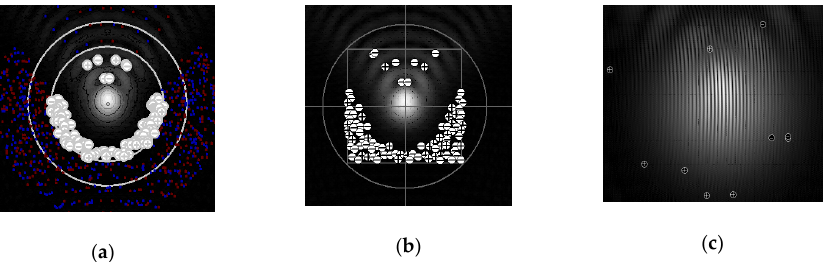
Figure 8. Distributions of singular points in a beam with a phase profile set by polynomial No. 8 (coma). The dislocations are shown by circles with «+» or « − » signs. To register optical vortices three algorithms were used. Firstly, vortices were localized by processing distribution of wavefront gradients ( a ); secondly, as a point of intersection of isolines ( b ); and with application of interferometric algorithm ( c ). The number of the found singular points N dsl = 98 ( a ), N dsl = 92 ( b ) и N dsl = 10 ( c ). The normalized path length was equal to 0.1.